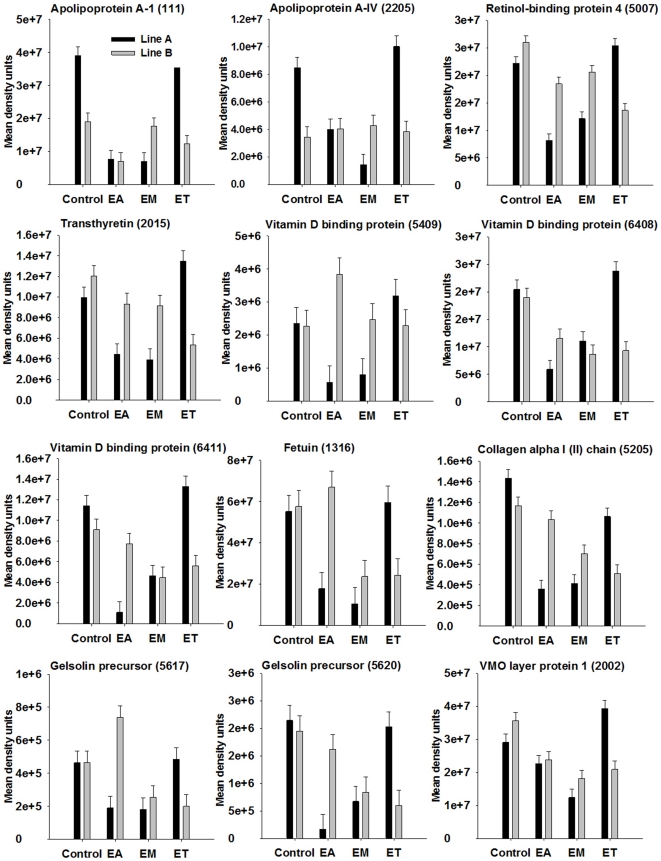
Broiler genetic line×coccidia infection interactions (P<0.001) for cargo and structural proteins.Line A and B broiler chicks were either not infected (control) or were inoculated with 1 of 3 Eimeria species, E. acervulina (EA), E. maxima (EM) or E. tenella (ET) at 15 d post-hatch. At 21 d (6 d post-infection) serum was harvested from whole blood samples and used for 2D gel electrophoresis followed by MALDI TOF/TOF. Protein density was evaluated by densitometric analysis of spot intensity followed by ANOVA. Values represent mean density units ± SEM (N = 6).